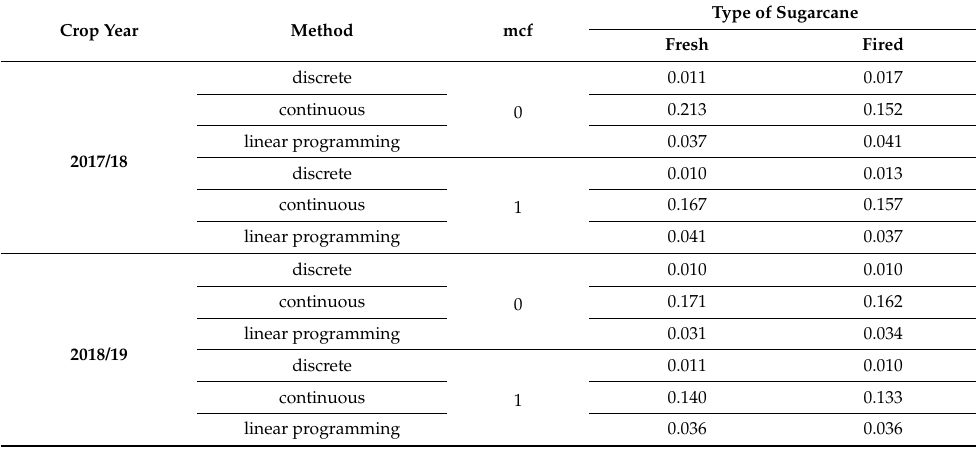
Table 8. CPU time (seconds) of fresh and fired sugarcane cutting in each day in crop year 2017/18 and